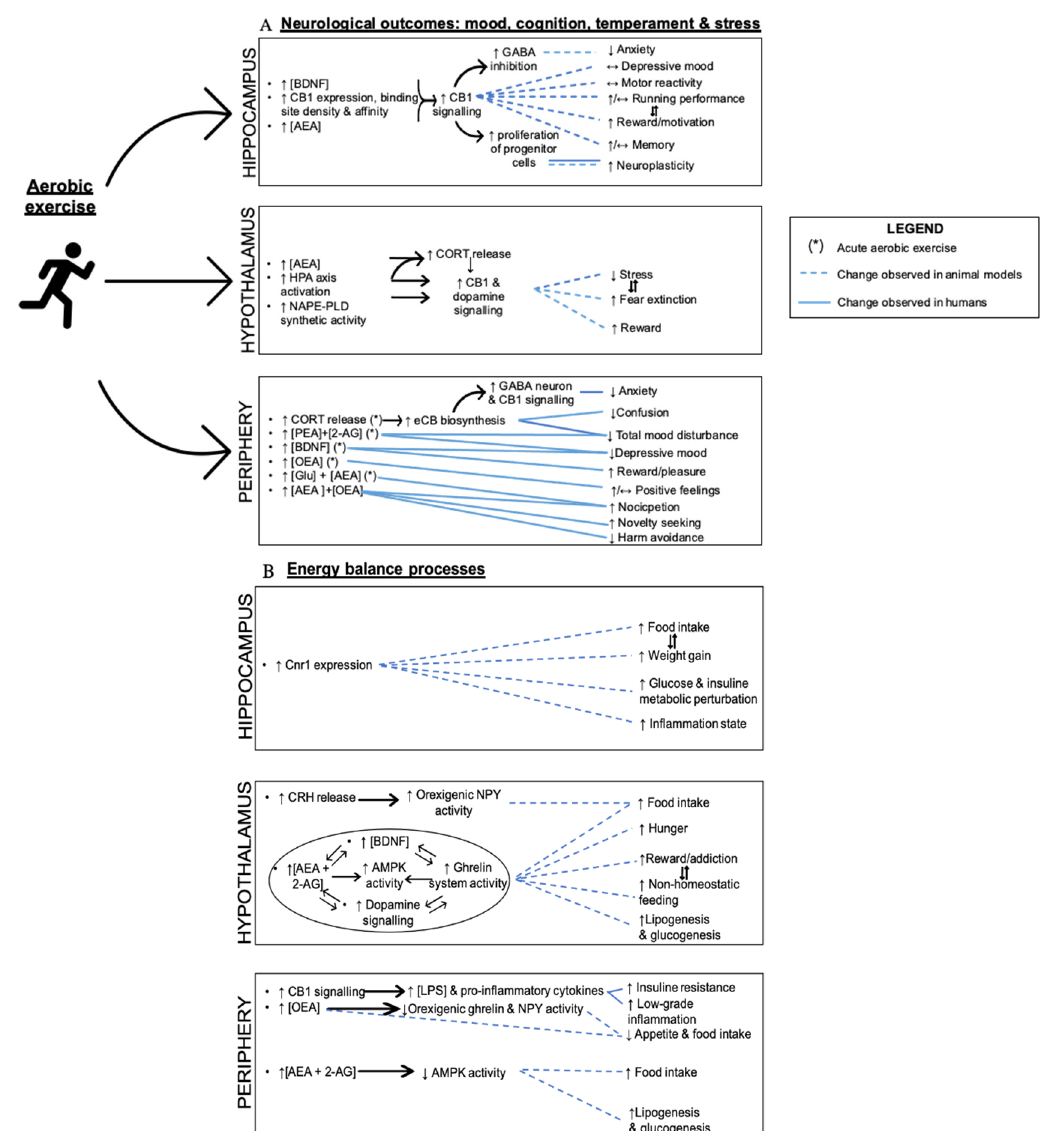
Figure 2. The possible ECS-related neurological outcomes of aerobic exercise and metabolic processes in hippocampal, hypothalamic, and peripheral tissues. The eCBs are involved in brain and exercise interactions. ( A ) Cross-sectional and prospective studies have been selected and used to summarize the implication of eCBs in mood, temper, cognition, and motor skills in relation to acute and chronic aerobic exercise. Looking at the hippocampus, aerobic exercise was associated with the increase of CB1 signaling and hippocampal BDNF expression (Ferreira-Vieira et al., 2014), exerting a neutral to positive impact into neuroplasticity and mental factors in animals. In the hypothalamus, the HPA axis and CB1 signaling reduce stress and fear. In the periphery, aerobic exercise seems to have positive impacts on the phenotype of human brain factors through the rise of OEA, AEA and a cortisol-AEA-GABA cascade. ( B ) The eCBs also impact on metabolism, thus playing a secondary neurological role. In the hippocampus, some animal studies suggested that CB1 overactivity would lead to inflammation and obesity-related consequences such as hyperphagia and glucose intolerance. The hypothalamic AMPK, eCBs, dopaminergic and ghrelin systems might interact to activate feeding, as well as CRH release. In the skeletal muscle, liver and adipose tissues of humans and animals, eCB/CB1 signaling would play the same role with possible inhibitory effects by OEA. CB1 signaling would also increase lipopolysaccharide (LPS) levels, low-grade inflammation, and insulin resistance. Physical activity and diet could be putative triggers of energy seeking molecular mechanisms and be implicated in inflammatory processes.